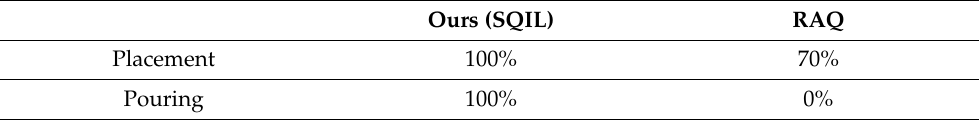
Table 5. Comparison table with reinforcement learning realized by RL with active queries.